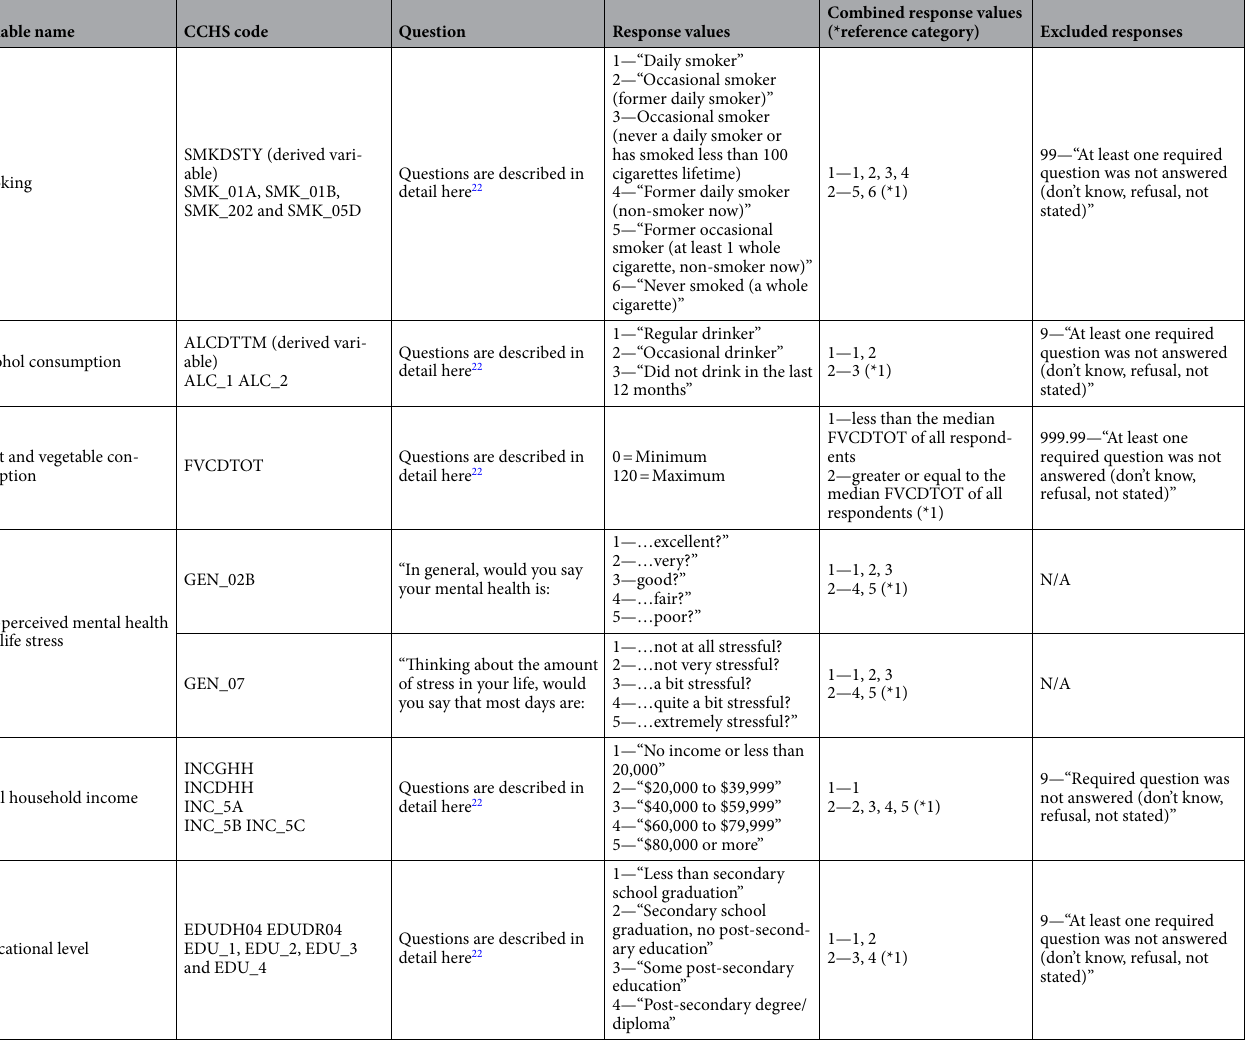
Table 5. Lifestyle and socioeconomic factors. CCHS Canadian Community Health